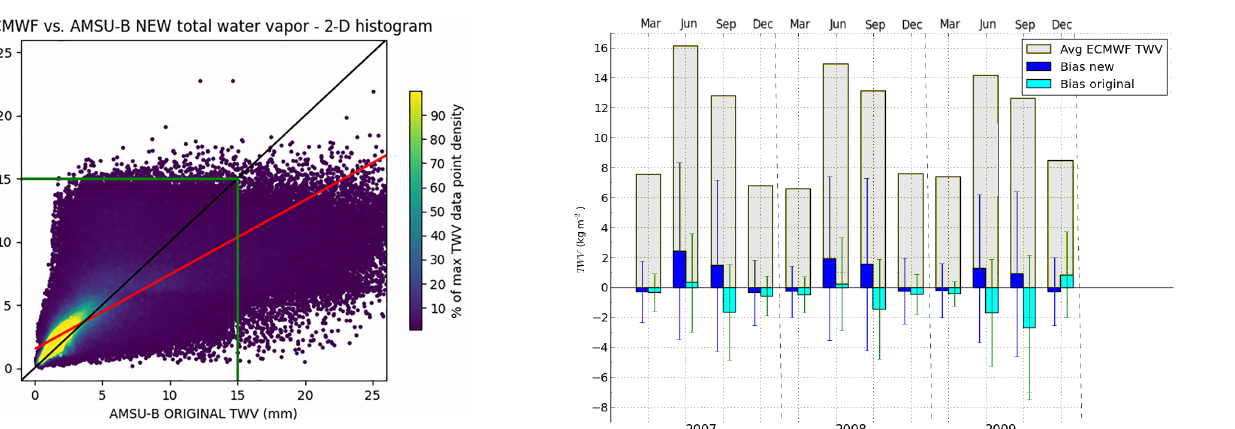
Figure 10. Bias comparison of the original and new AMSU-B TWV retrieval versus ECMWF data. Error bars represent the RMSD be- tween the retrieved TWV data and ECMWF